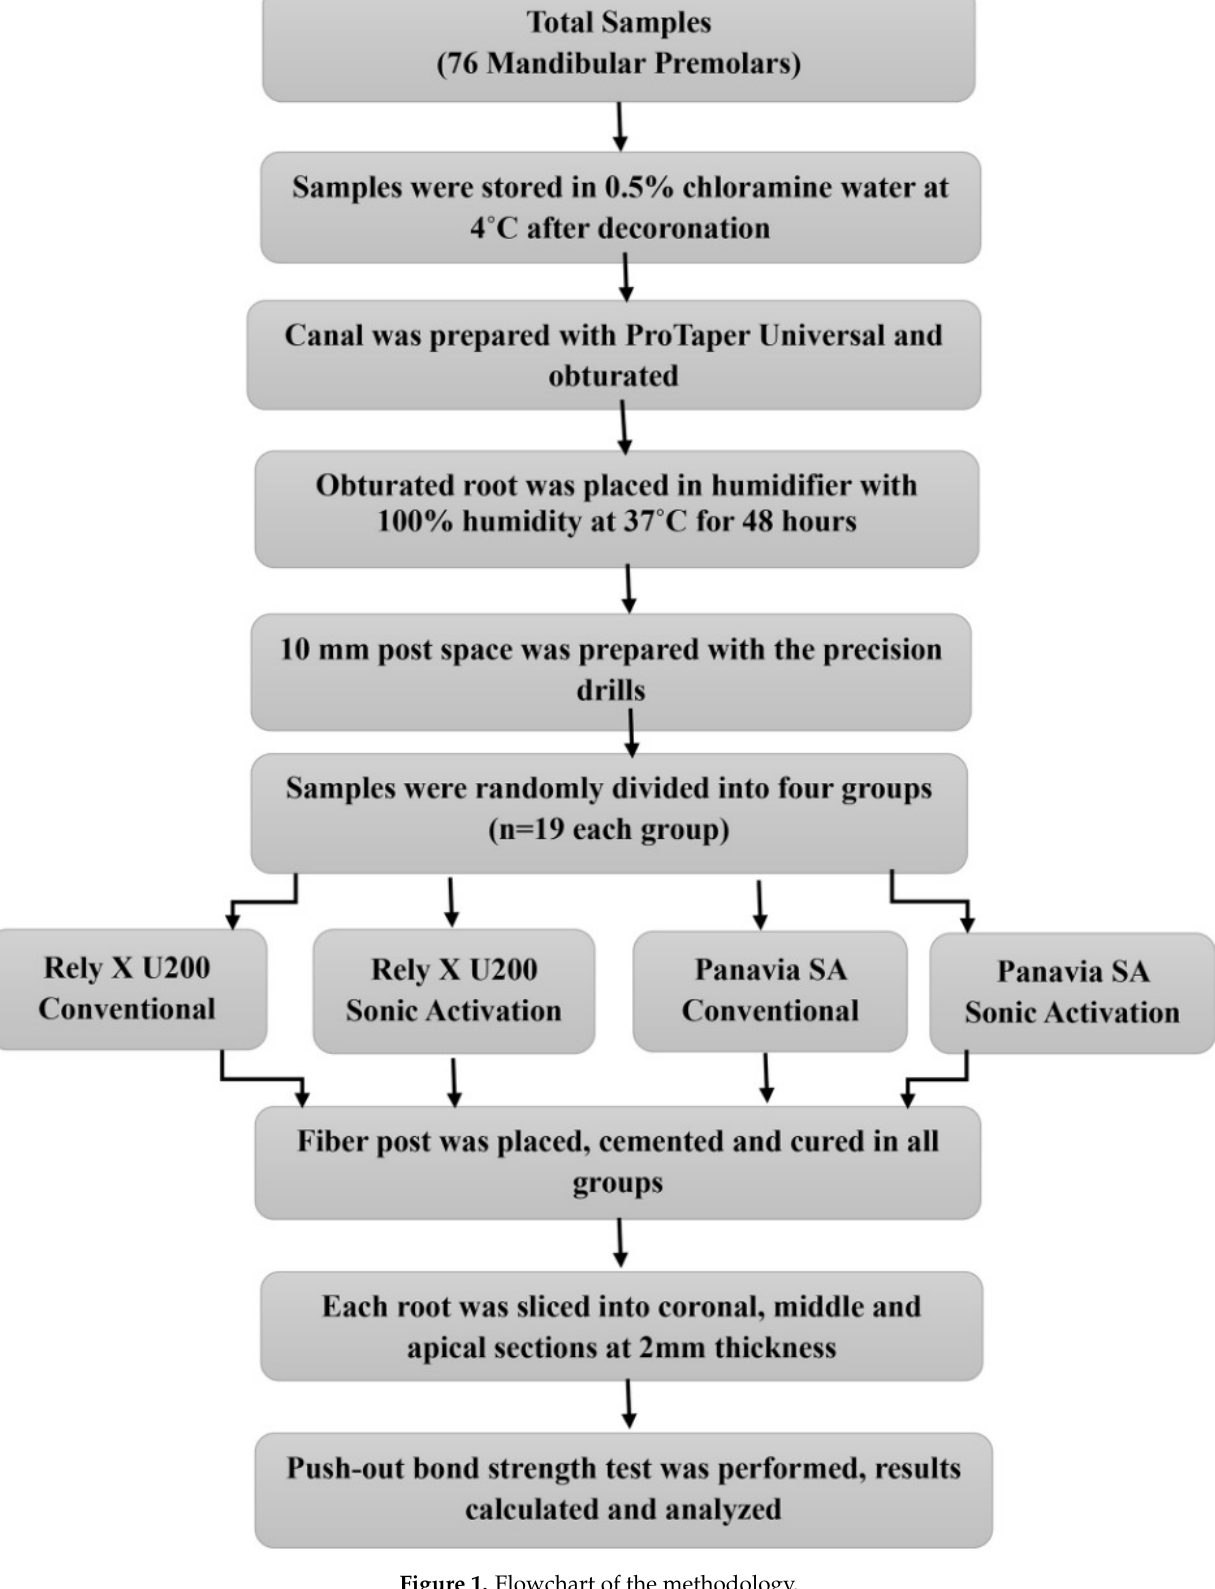
Figure 1. Flowchart of the methodology.